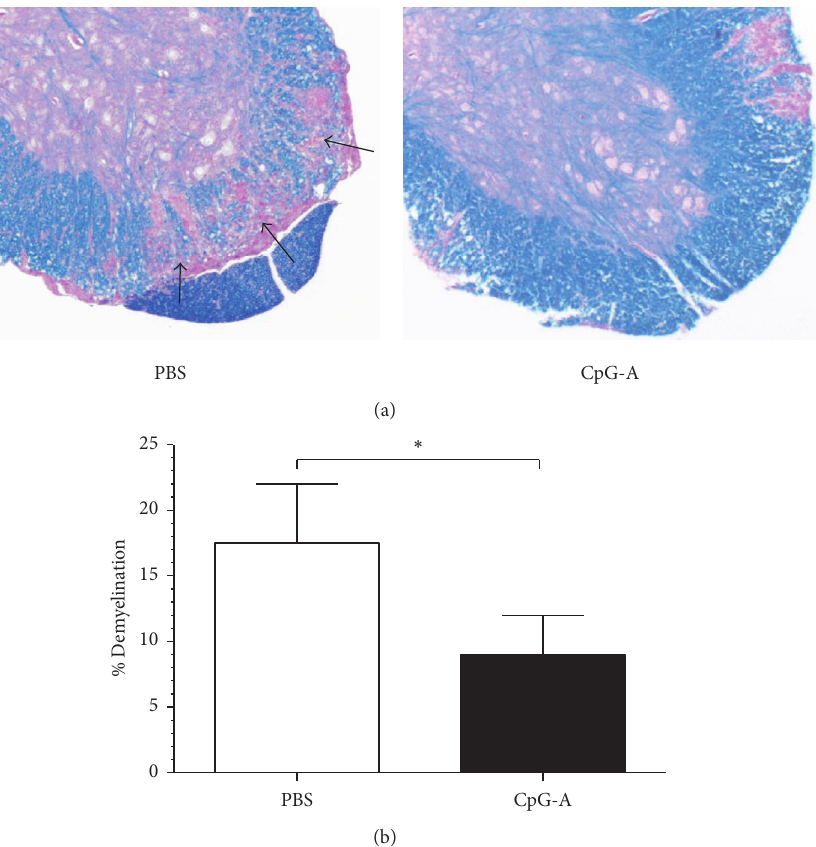
Figure 2: Decreased CNS demyelination in mice treated CpG-A during EAE. (a) Representative Luxol fast blue (LFB) staining of spinal cord sections from MOG-immunized mice treated with PBS or CpG-A to visualize demyelinization (arrows). Images are representative of one experiment out of three. (b) Quantification of spinal cord demyelination at day 20 after immunization in mice treated with PBS or CpG-A. Depicted are means ± sem in one representative of two. 𝑛 = 5 ; ∗ 𝑝 < 0.05 , two-tailed Mann–Whitney